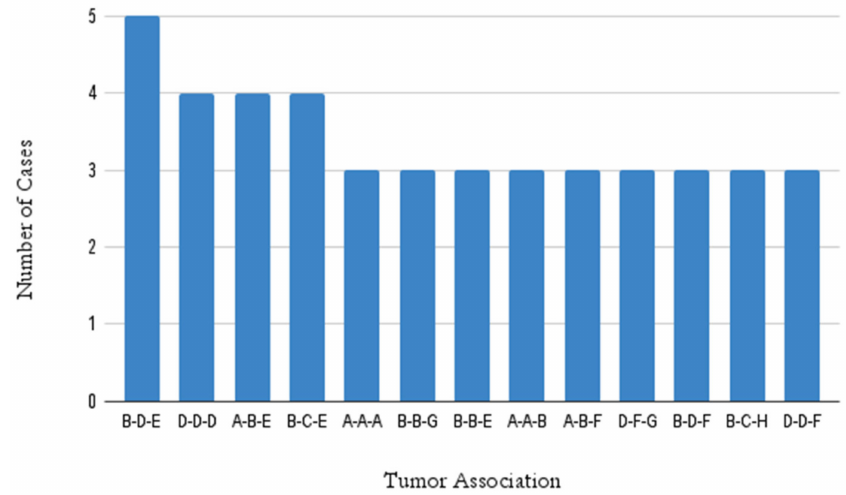
Figure 1. Distribution of triple tumors Association patterns. A—Digestive system; B—Genital tract; C—Lung; D–Skin; E—Breast tissue; F—Lymphoid and hematopoietic tissue; G—Other (includes the thyroid gland, mediastinum, bone, joint, soft tissue, eyes, brain, and central nervous system); H—Head and neck.